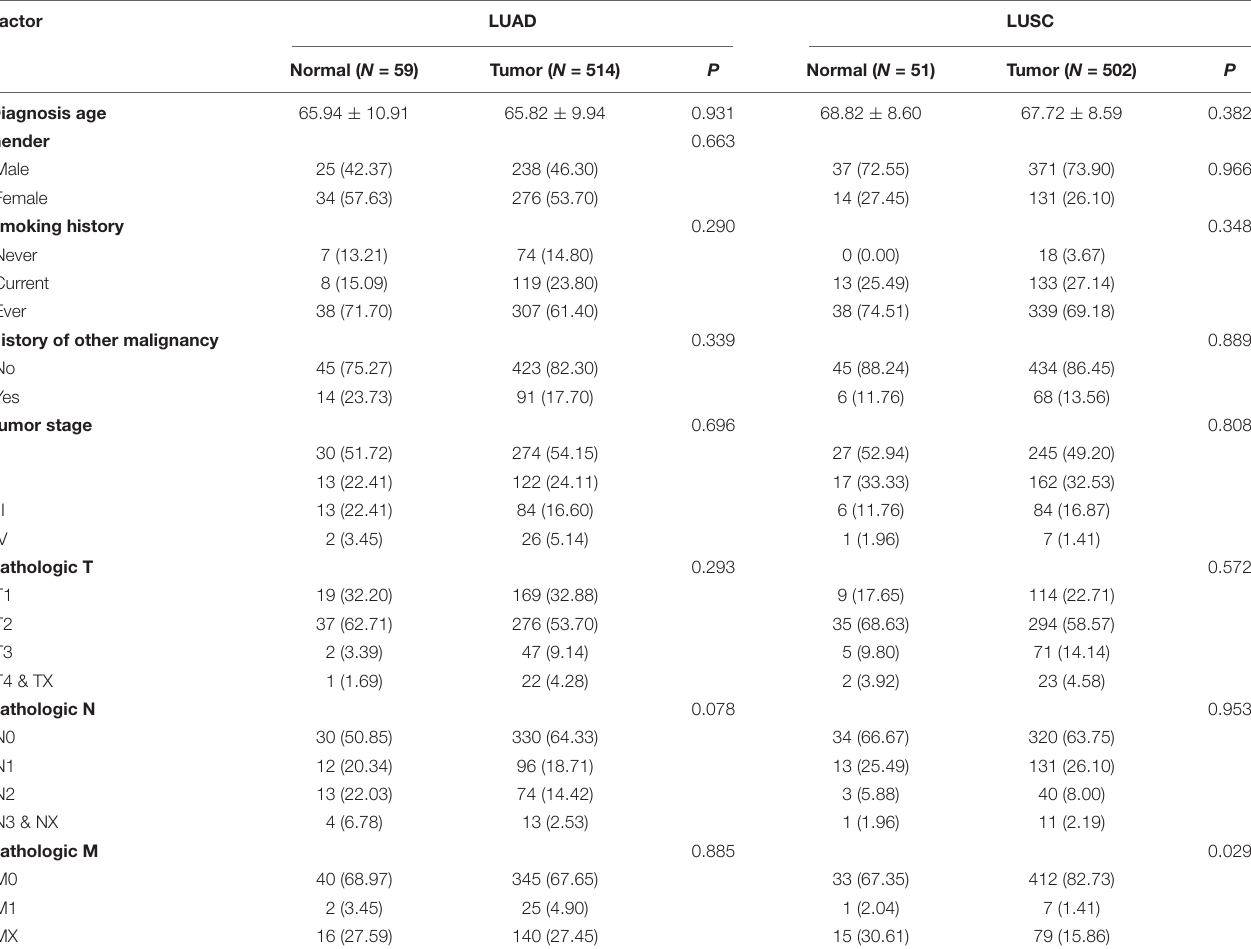
TABLE 1 | Baseline of